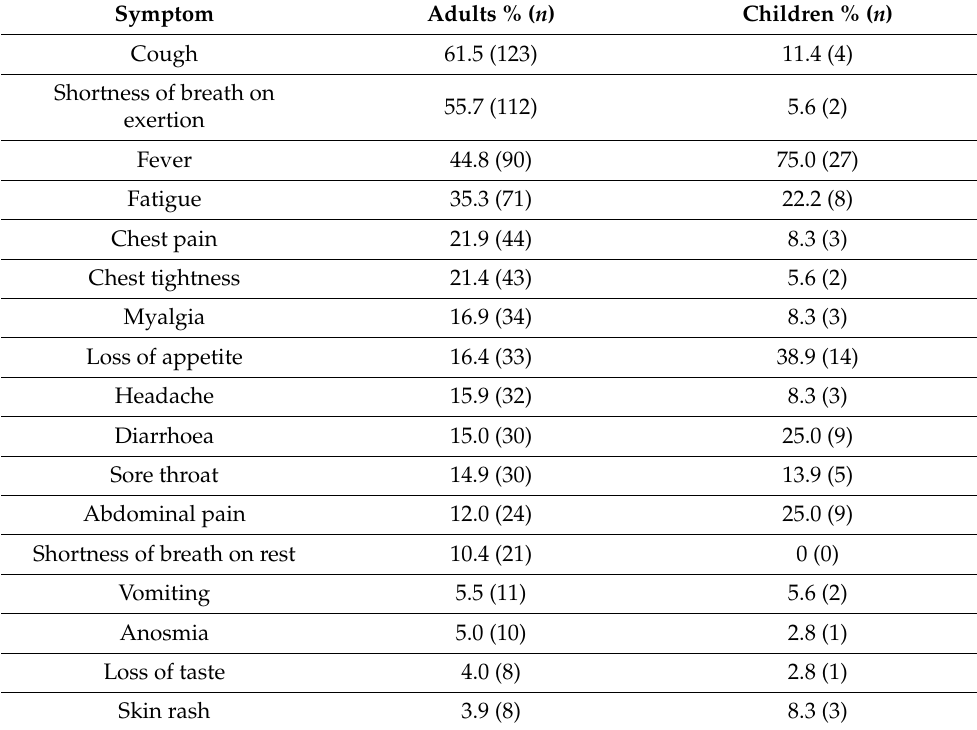
Table 2. Frequency of symptoms on referral to the COVID-19